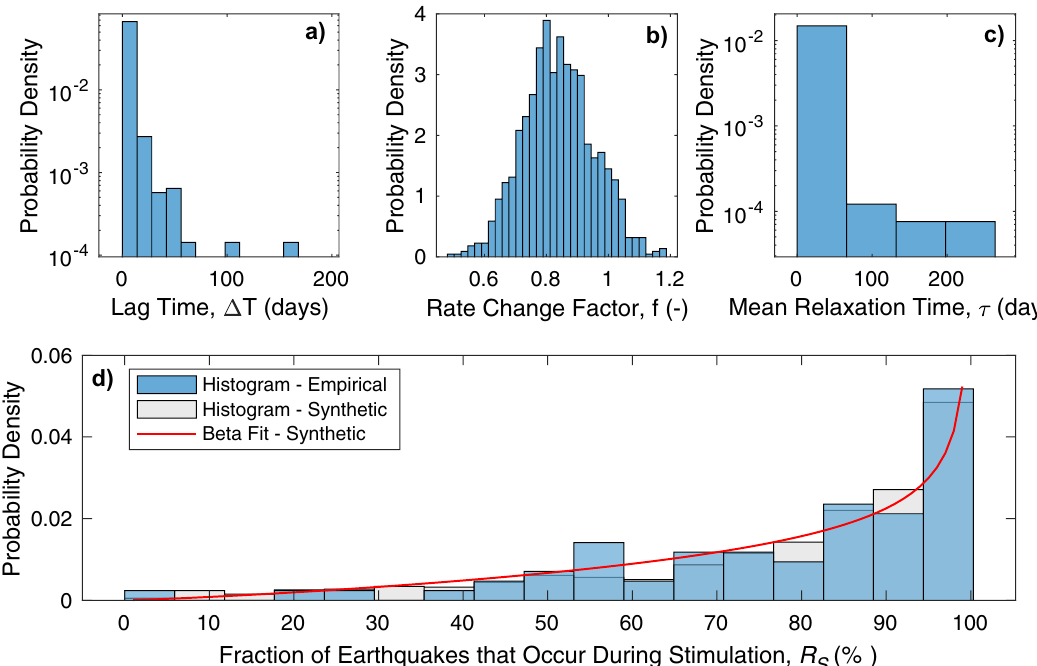
Figure 4. Synthetically fitting the R S distribution to model parameters. ( d ) The archetypal model for trailing seismicity ratios (Eq. 8) is fit (grey bars) to the empirical distribution of R S (blue bars). The distribution of model parameters ( a ) ΔT, ( b ) f , and ( c ) τ are also shown.